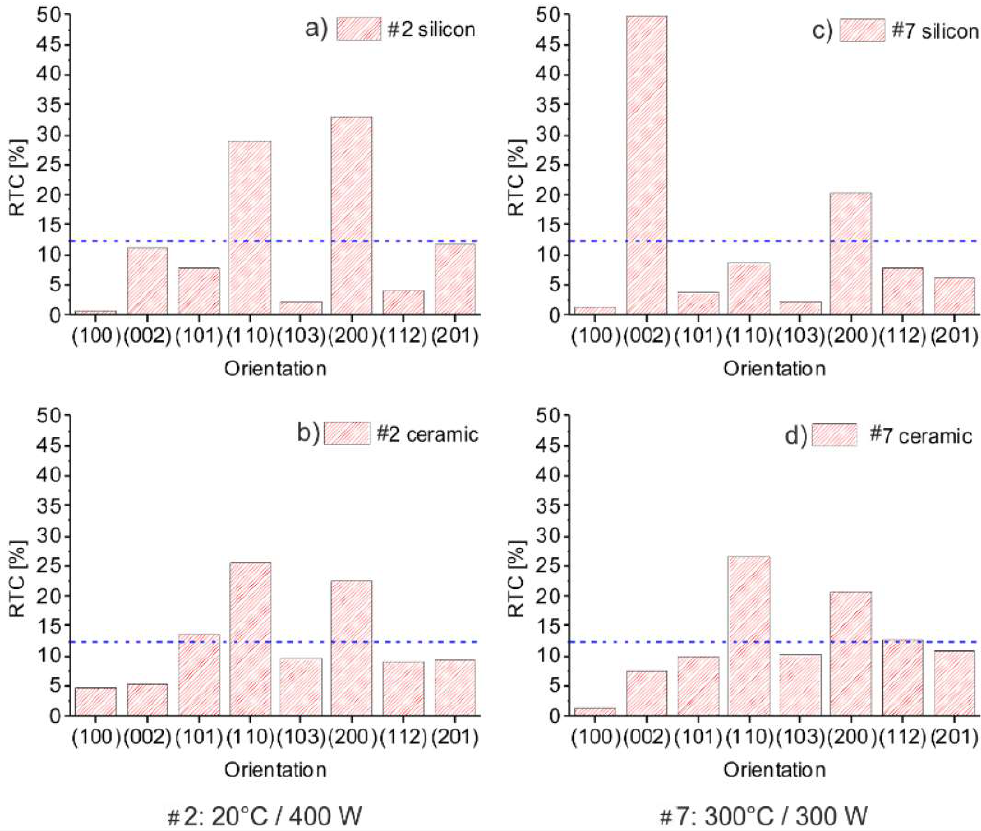
Figure 6. Comparison of RTC distribution for layers sputtered with N 2 /Ar ratio of 5% on ceramic and silicon: ( a ) #2 (silicon); ( b ) #2 (ceramic); ( c ) #7 (silicon); ( d ) #7 (ceramic). The blue line indicates the RTC value that would represent a polycrystalline material of the respective